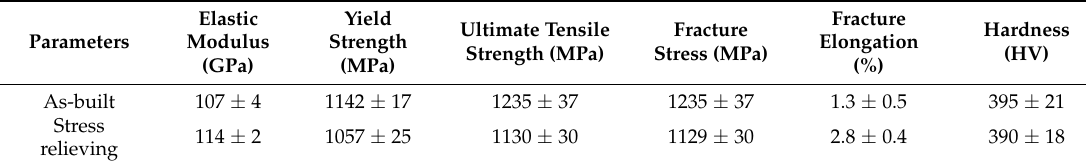
Figure 7. Stress strain curves of as ‐ built and stress relieving Ti6Al4V parts. Table 4. Tensile properties of SLM Ti6Al4V samples.